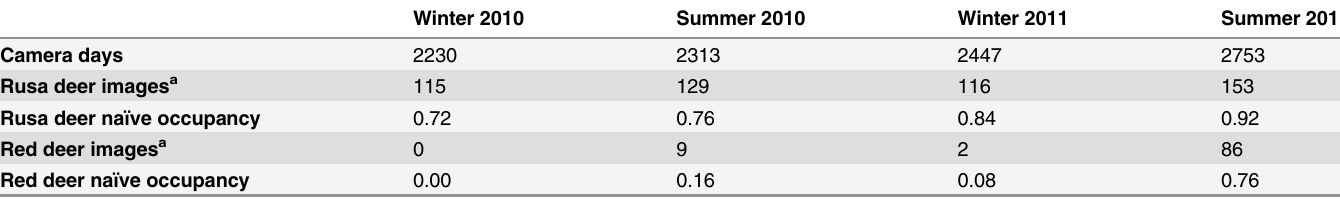
Table 1. Summary of the camera trap data for rusa deer and red deer by year and season.